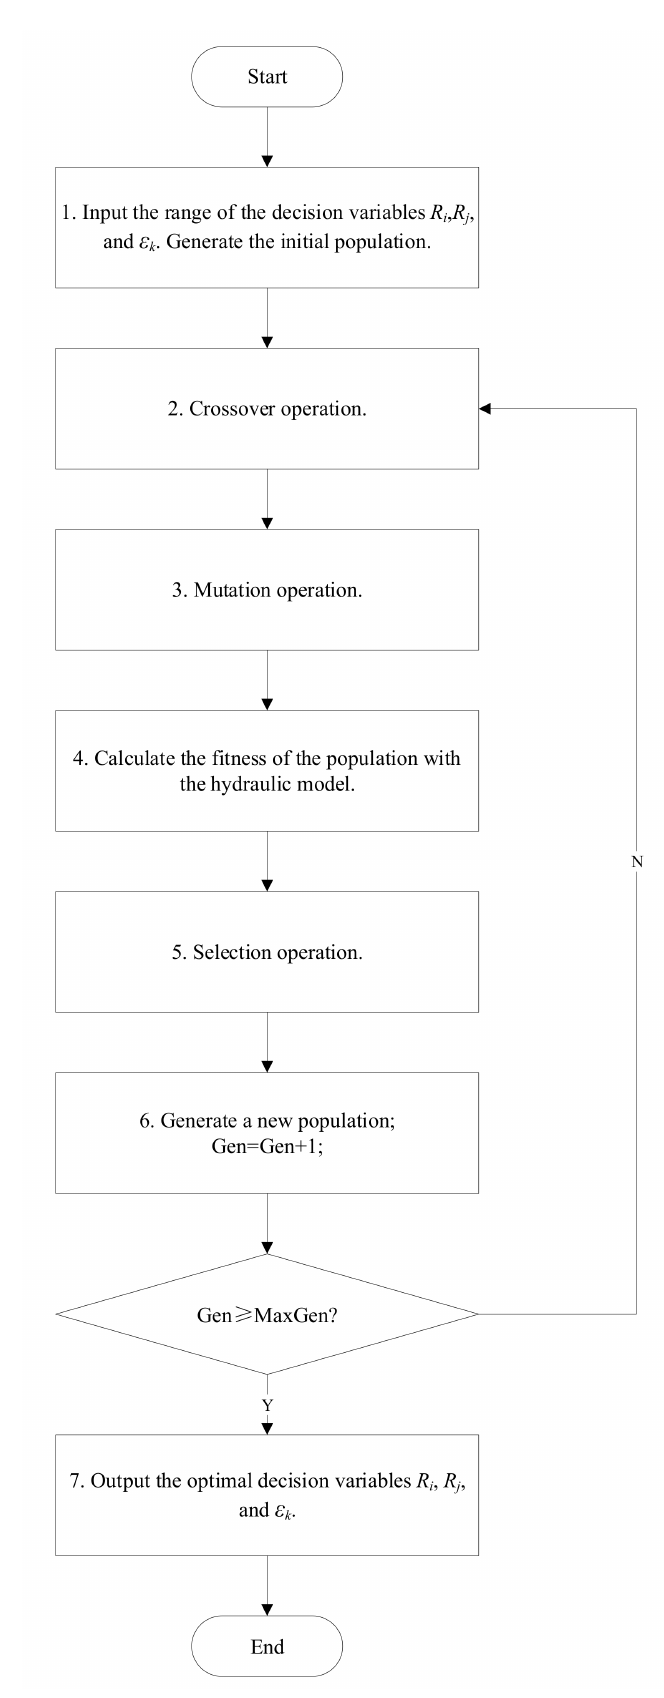
Figure 4. Scheme of the GA